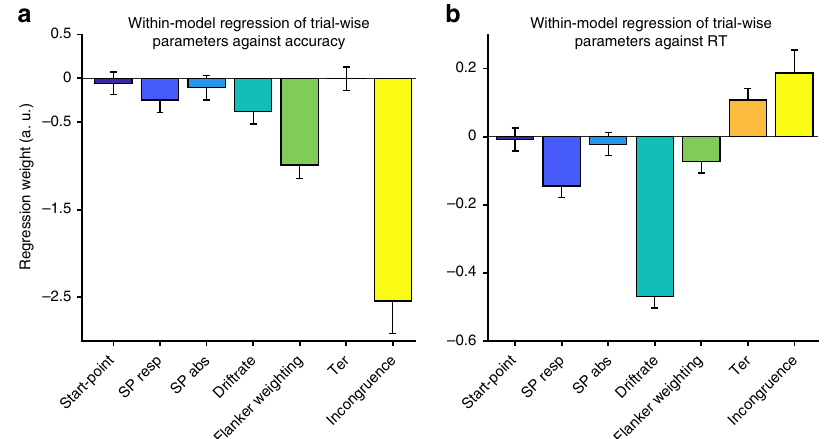
Fig. 3 How model parameters in fl uence accuracy and RT. Displayed are regression coef fi cients of a single-trial regression analysis within the DDM using trial-wise variance parameters. The goal of this analysis was to delineate which parameters have strong impact on whether a trial will be correct ( a ) or fast ( b ). Akin to the participant data (Fig. 1), we used logistic and multivariate regression to investigate accuracy and RT, respectively. In both models, a trial ’ s incongruence had a strong impact (yellow, compare to Fig. 1b, h). Variance in the start-point of the decision process of each trial did not overall in fl uence accuracy and RT. However, how much the start-point was biased towards the response the model later on selected, signi fi cantly decreased accuracy and RT (factor SP Resp ). This effect was less pronounced for the absolute bias per trial (factor SP Abs ). Trialwise faster drift rates signi fi cantly decreased RT and much less so accuracy. When fl ankers were more strongly suppressed ( f is lower), accuracy increased and RT slightly decreased. Non-decision time ( T er ) did not in fl uence accuracy, but longer T er on each single trial led to increased RT. Error bars re fl ect 99.9% CI, plotted are regression weights for one DDM that employed the group mean parameters for all post-correct trials and simulation of 5.000 single